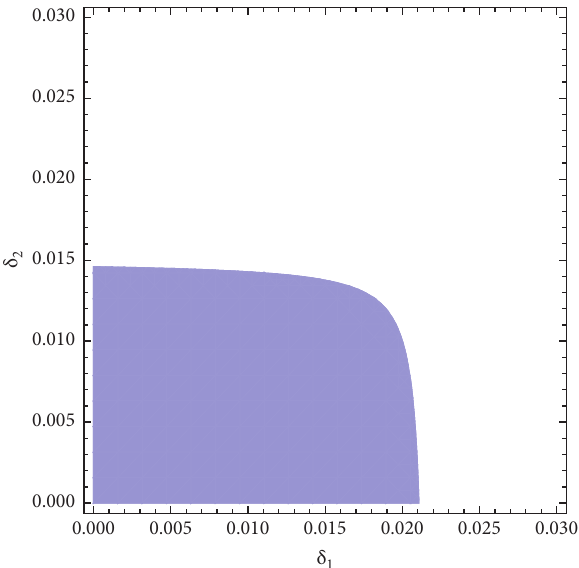
Figure 2: The stable region of dynamic system